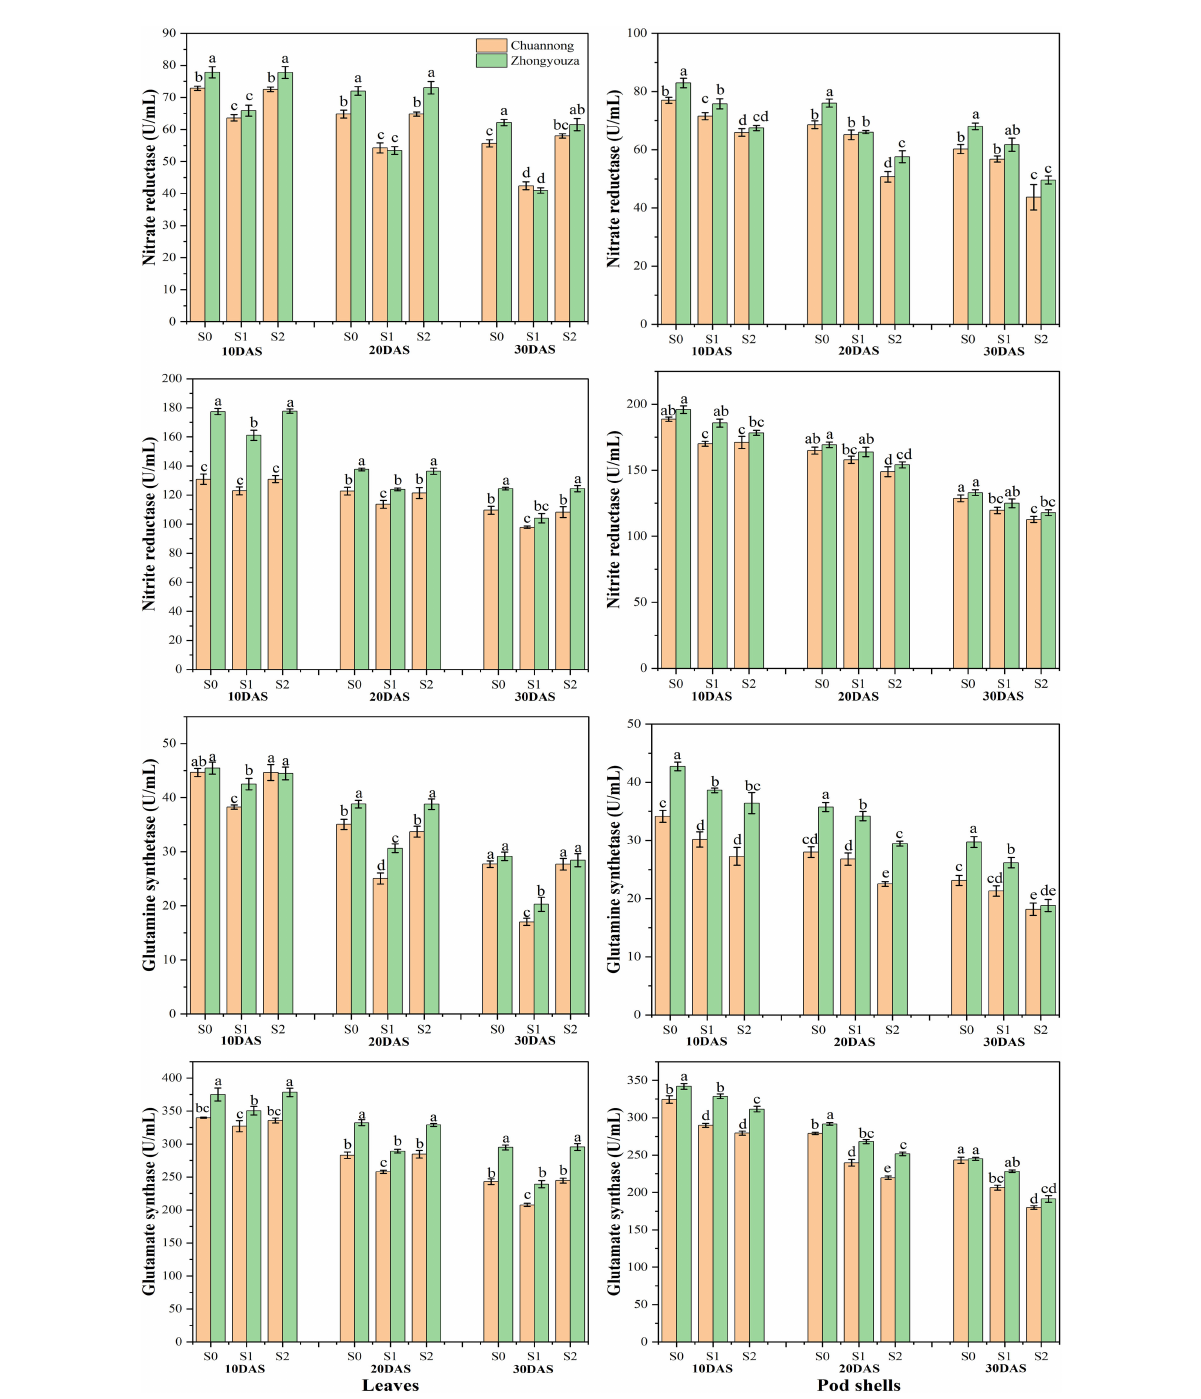
FIGURE 6 N mobilizing enzymatic activities under shade stress. S0= control (ambient light); S1= shade at the whole fl owering stage and S2= shade at the start of pod development to pod maturity. Values were determined using the LSD test, and various small letters denote the signi fi cance level of treatments at the 0.05 probability level (Duncan